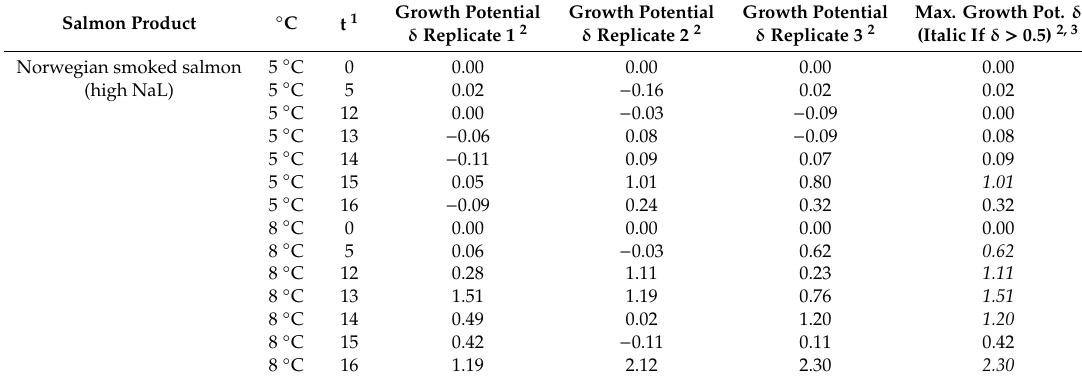
Table 5. Growth potential δ of L. monocytogenes in Norwegian smoked salmon injected with 30% NaL, according to Commission Regulation (EC) No 2073 /